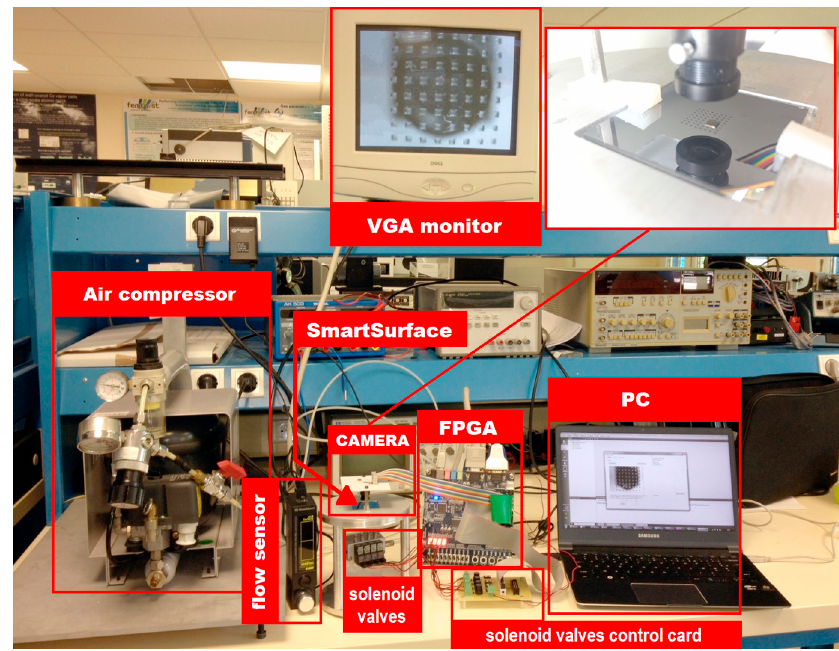
Figure 17. Overview of the experimental setup.